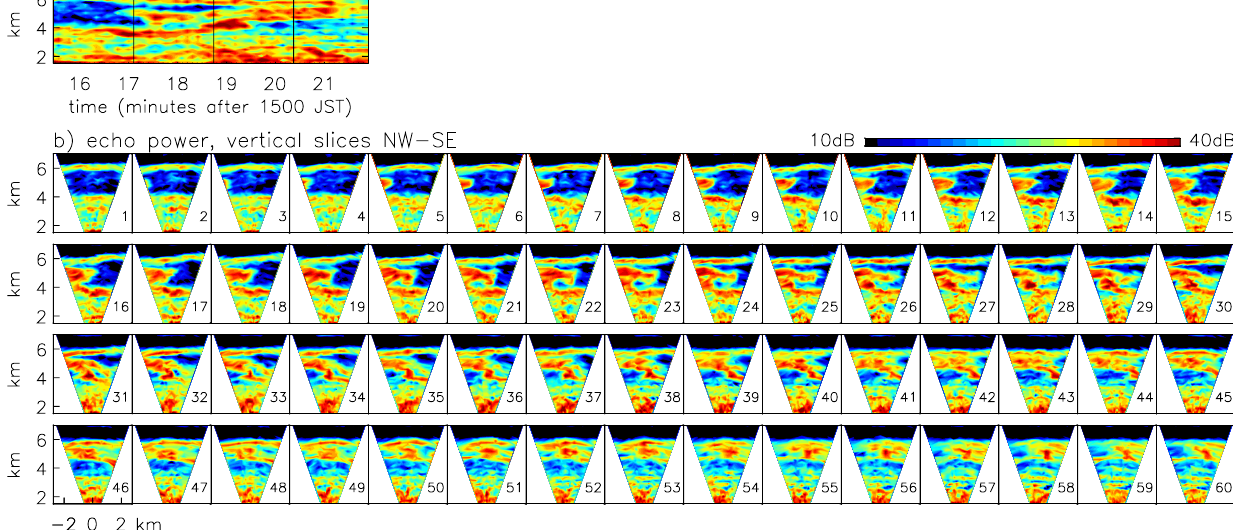
Fig. 9. (a) Height-time plot of vertical-beam echo power on 16 July 2002. (b) Vertical slices of echo power in NW–SE azimuth, numbered 1–60, for same time and height as (a). Vertical and horizontal axes are both 5.5km and time step 6.55s. A 1-km tall breaking wave moves southeast above the radar at 5km AGL, overturning in plots